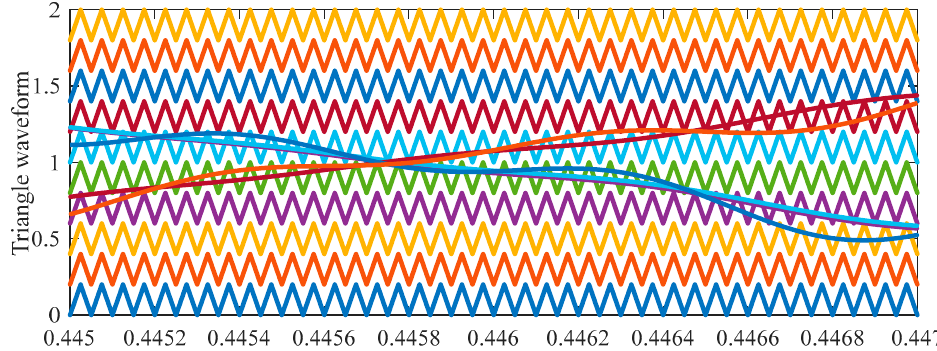
Figure 6. The 10-level triangle waveforms used.